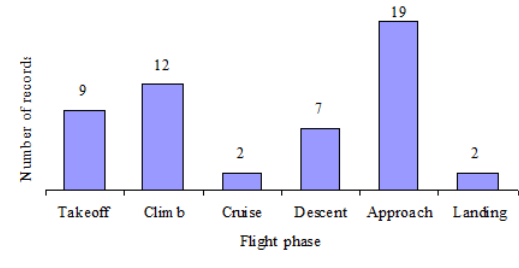
Figure 2. Records encounter classification with respect to flight phases